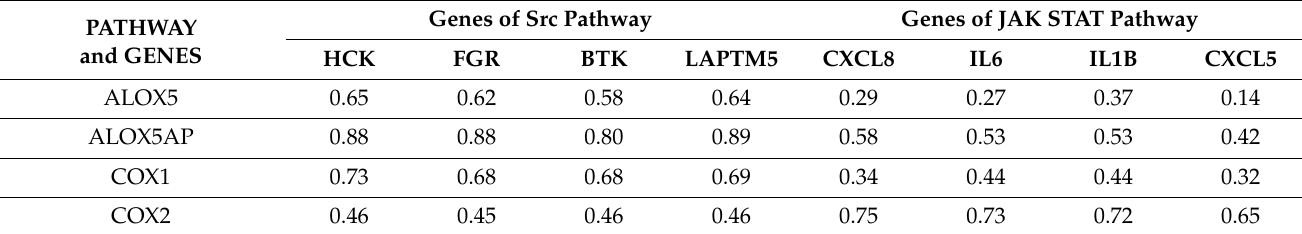
Table 2. Correlations of ALOX5, ALOX5AP, COX1 and COX2 with Src and JAK STAT genes in colorectal